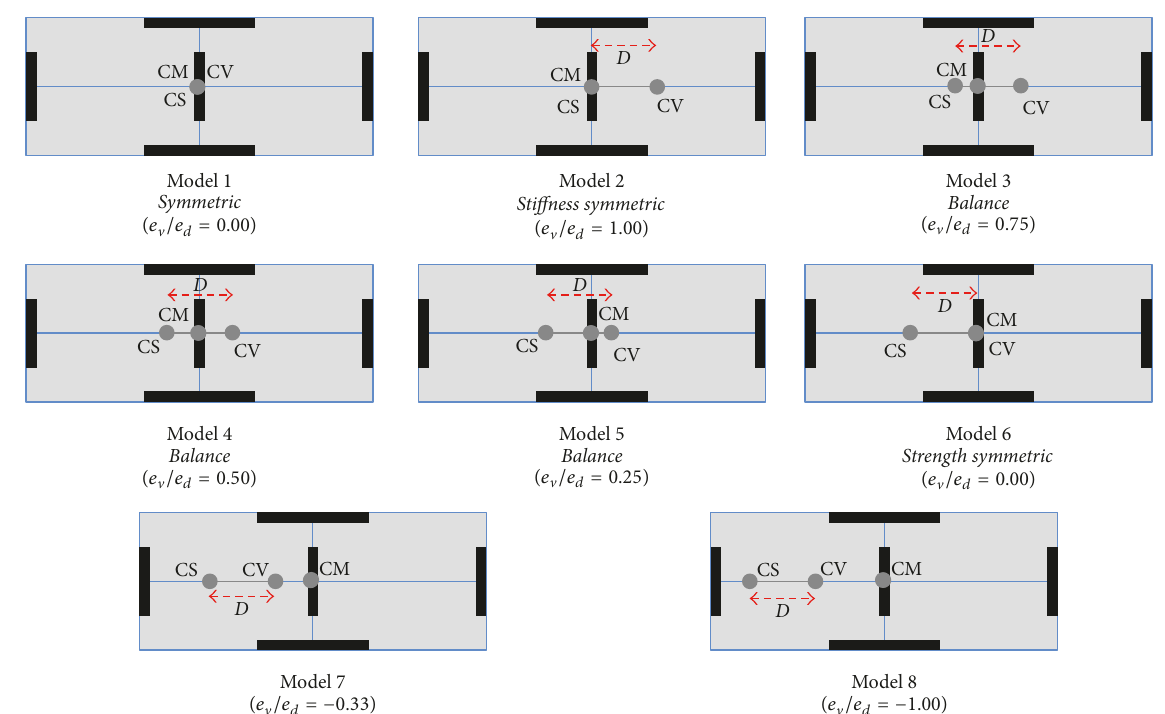
Figure 3: Schematic view of centers configuration in models (distance is not in